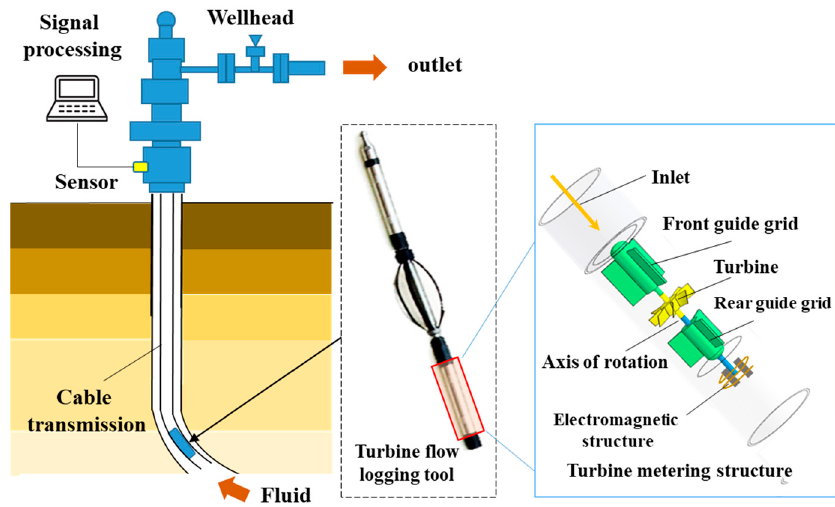
Figure 1. Schematic Diagram of Working Process Turbine Flow Well Logging Tool.